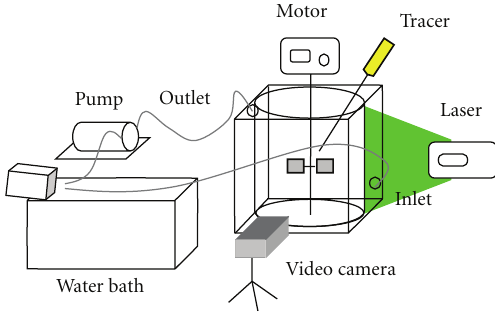
Figure 1: Experimental apparatus for flow visualization.